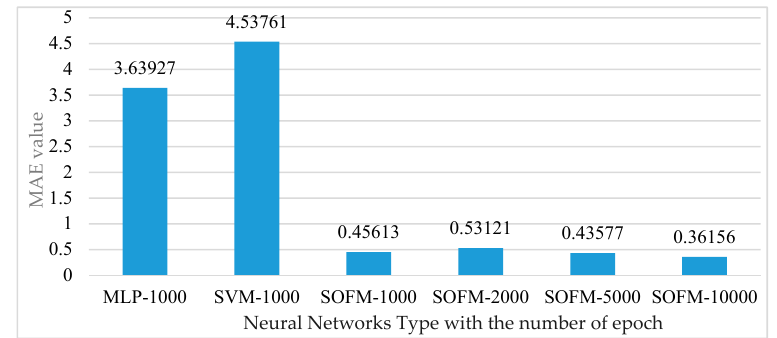
Figure 18. The comparison of MAE using different types of neural network models.